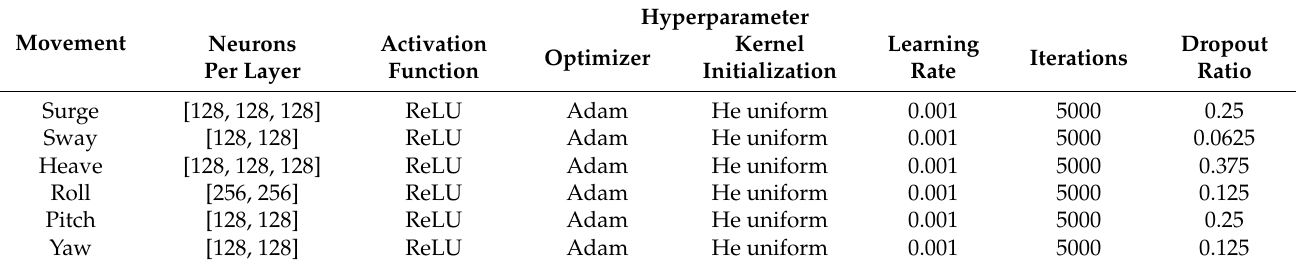
Table 3. Neural networks: best models’ hyperparameters.